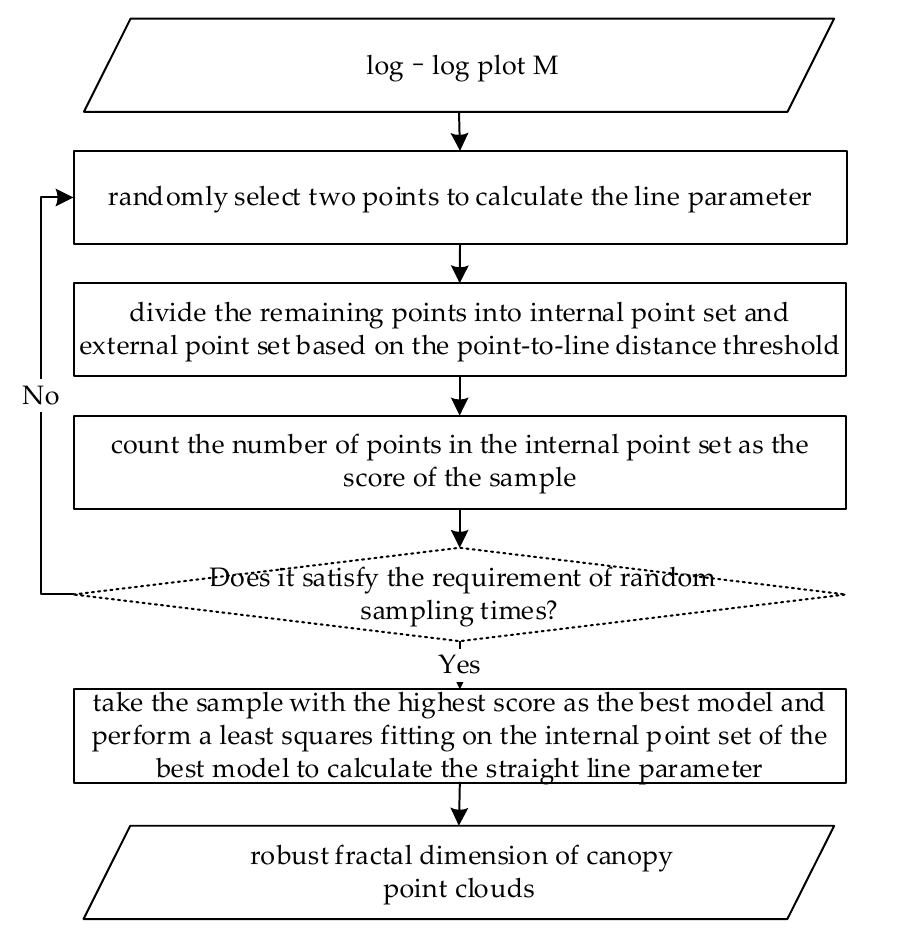
Figure 5. The method of calculating the box-counting dimension based on the RANSAC gross error elimination algorithm.